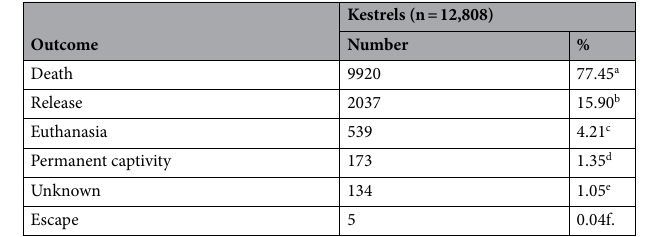
Table 2. Number and percentage of the total number of common kestrels admitted to rehabilitation centres in the period from 2010 to 2019 according to the outcome. a-f The values with different superscript letters in a column are significantly different ( P < 0.05).